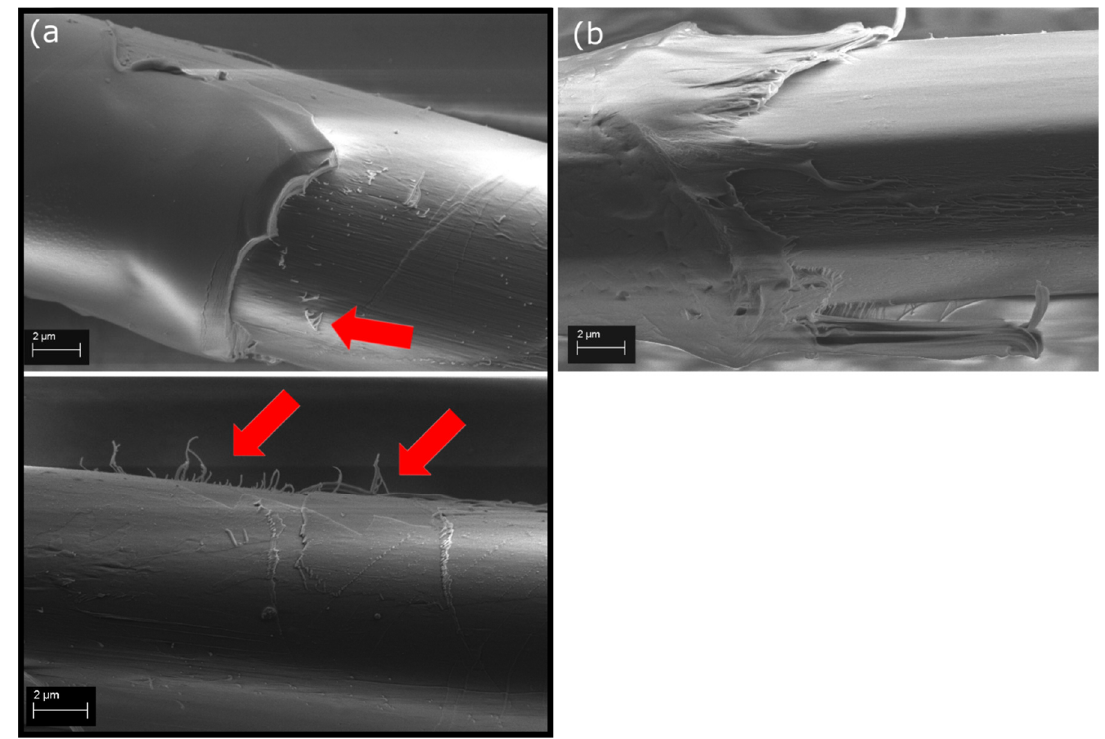
Figure 6. SEM images of the facture surfaces of ( a ) MW_EP, where red arrows indicate the fibrillation and peeling of the fiber surface, and ( b ) MW_PP after IFSS testing.